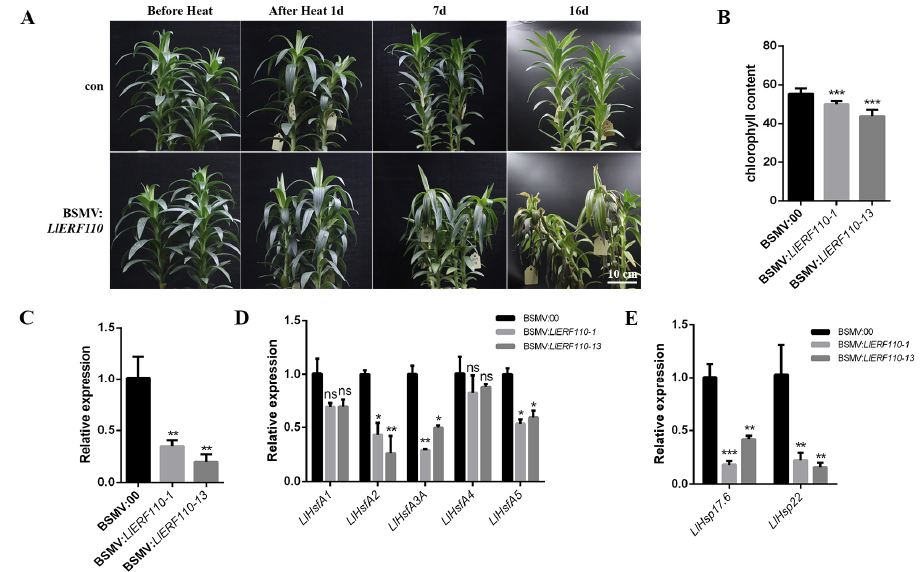
Figure 6. Phenotype of LlERF110 -silenced plants under heat stress and expression of HSFs and HSPs in silenced plants. ( A ) The phenotypes of the LlERF110 -silenced lines recovered at room temperature at 1 d, 7 d, and 16 d after treatment with heat stress at 42 ◦ C for 24 h. Bar: 10 cm. ( B ) Chlorophyll content in leaves of LlERF110 -silenced plants (BSMV: LlERF110-1 and BSMV: LlERF110-13 ) recovered at room temperature for 8 d after heat stress. ( C ) Expression of LlERF110 in silenced lines (BSMV: LlERF110-1 and BSMV: LlERF110-13 ) using qRT-PCR. ( D ) Expression of Hsfs in LlERF110 silenced lines. ( E ) Expression of Hsps in LlERF110 -silenced lines (BSMV: LlERF110-1 and BSMV: LlERF110-13